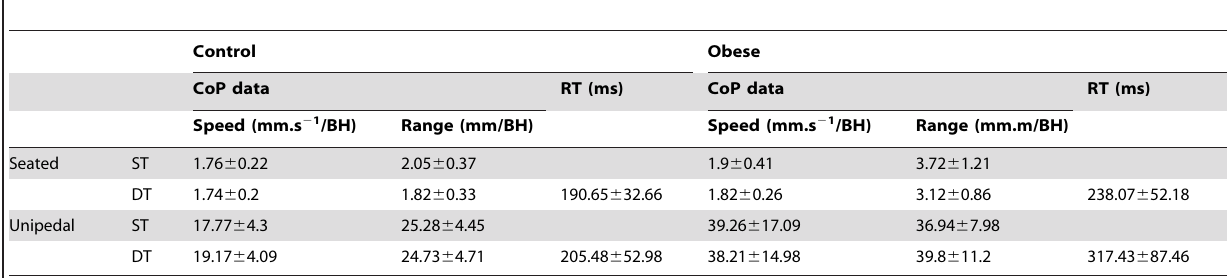
Table 1. Summary of the CoP data and RT for the two groups in the two postural conditions (mean 6 standard deviation) in simple task (ST) ans dual task (DT) conditions.